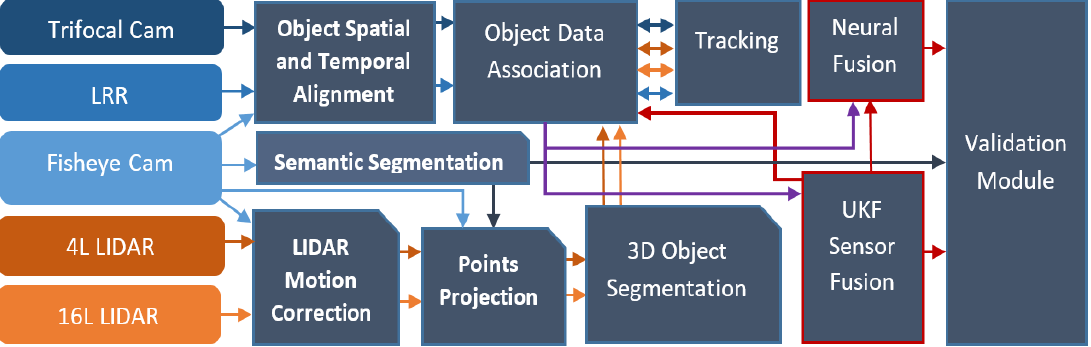
Figure 2. Processing pipeline used in the self-driving car solution. The flow of data from each sensor to the modules is depicted using the sensor or module color